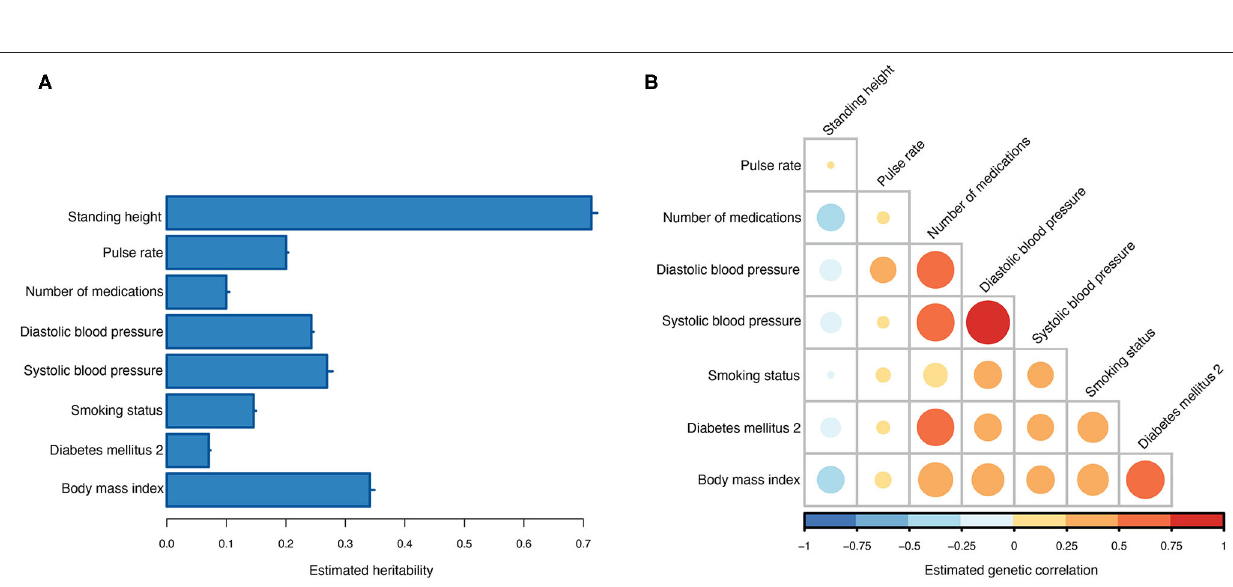
Frontiers in Medicine |